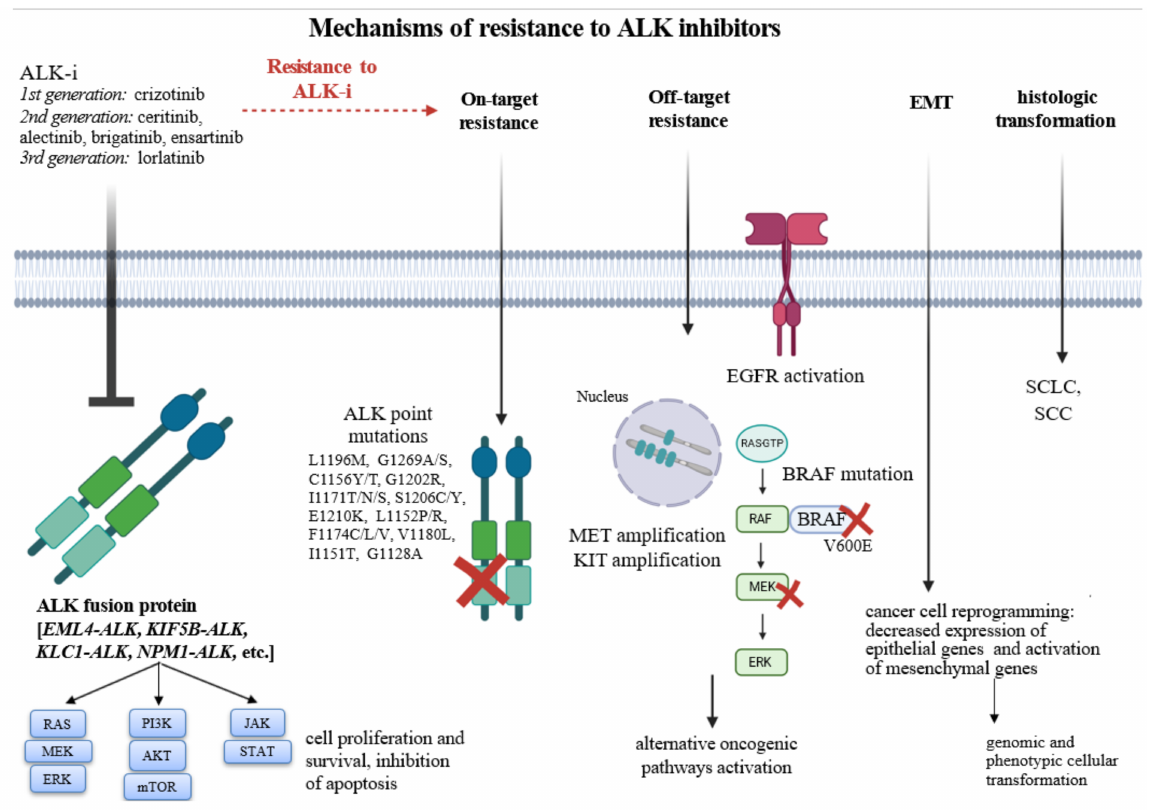
Figure 3. Mechanisms of resistance to ALK- inhibitors, including on-target and off-target molecular mechanisms. Abbreviations: ALK-i, ALK inhibitors; EMT, epithelial-to-mesenchymal transition; SCLC, small-cell lung cancer; SCC, squamous cell